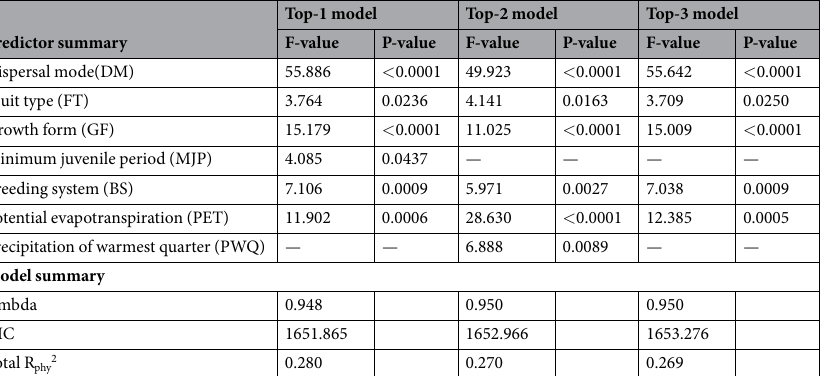
Table 4. Summary of the best multivariate phylogenetic models for seed mass as a function of traits and climate together. n = 725.